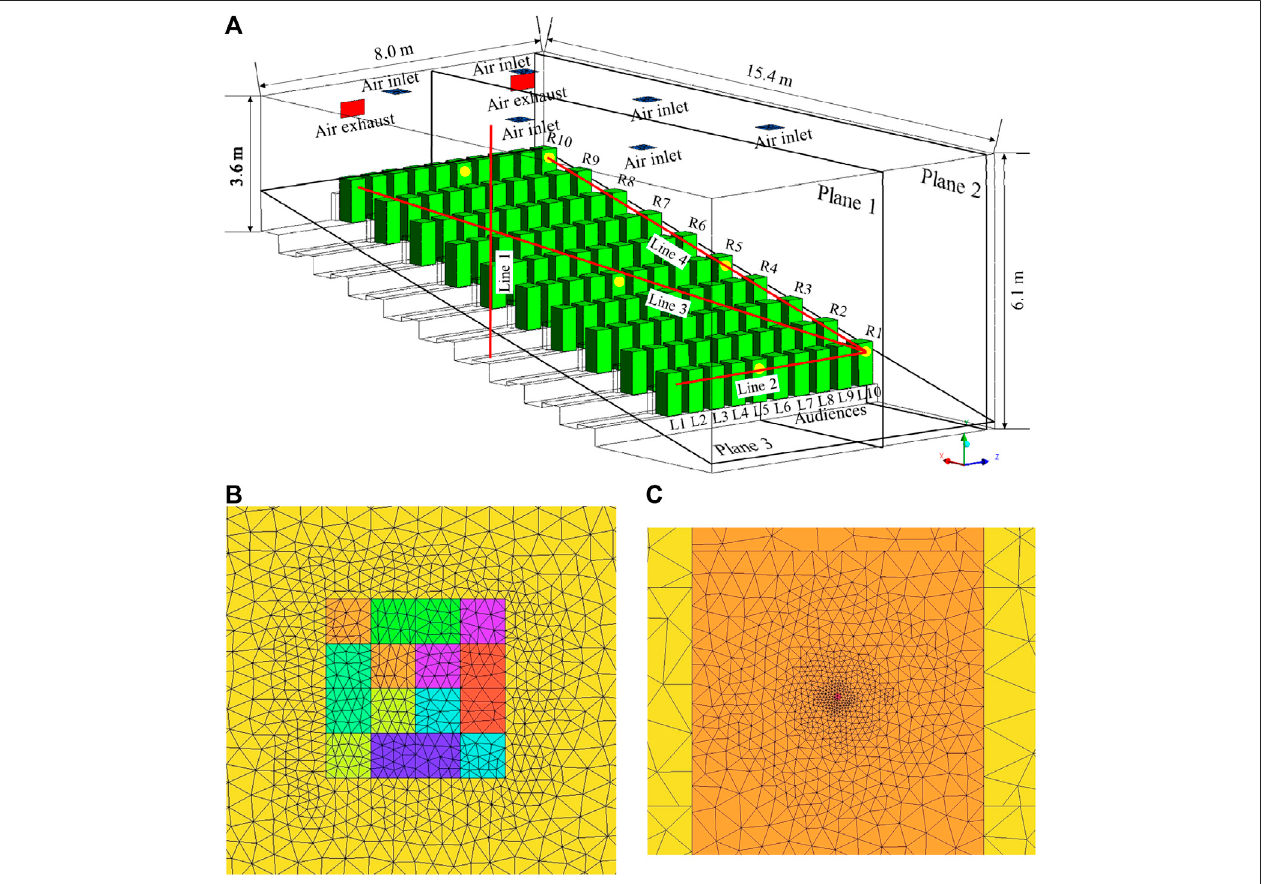
FIGURE 2 | Physical model and grid distribution of the theater hall: (A) physical model; (B) grid distribution at the ceiling and air inlet; (C) grid distribution at the audience and nose.